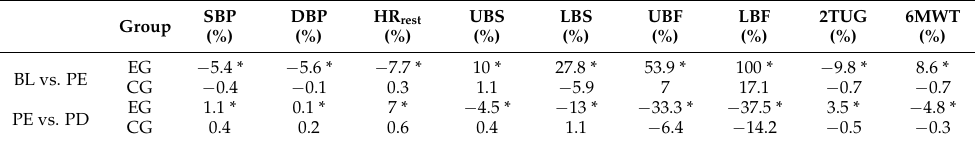
Table 2. Delta percentage differences of parameters after MEP and detraining period.